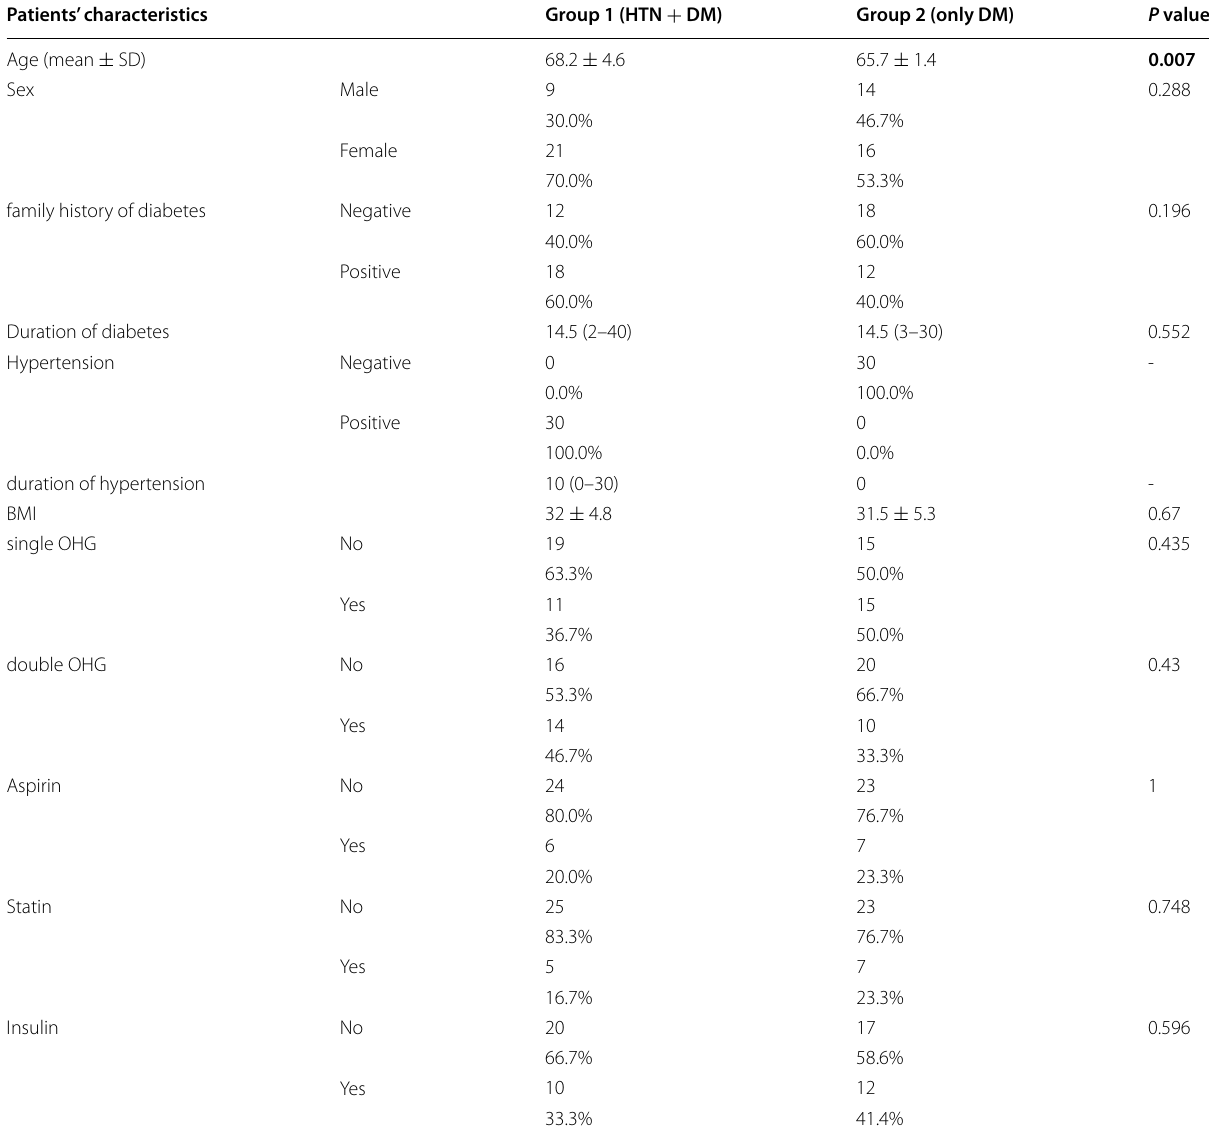
Table 1 Patient characteristics